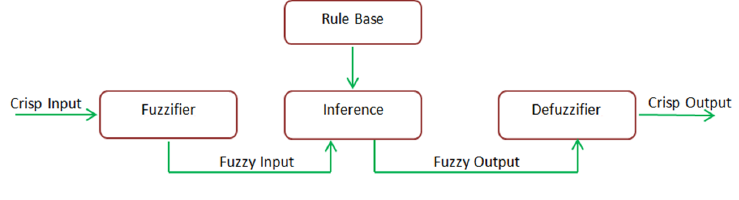
Fig. 7. Flow chart showing the application of fuzzy